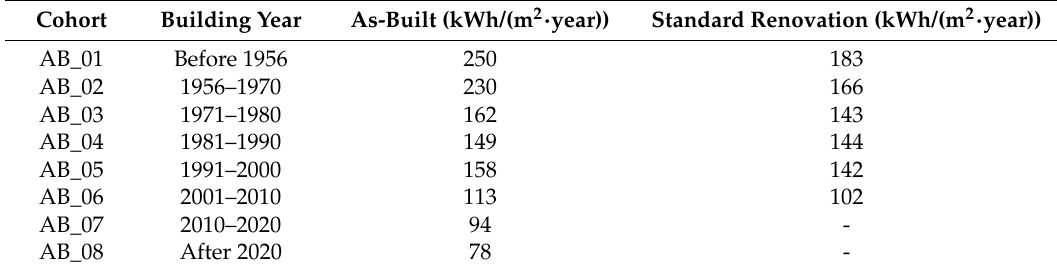
Table 7. Total energy need from 80/60 ◦ C models in IDA ICE, including electricity and 25 kWh/(m 2 · year) DHW added after the